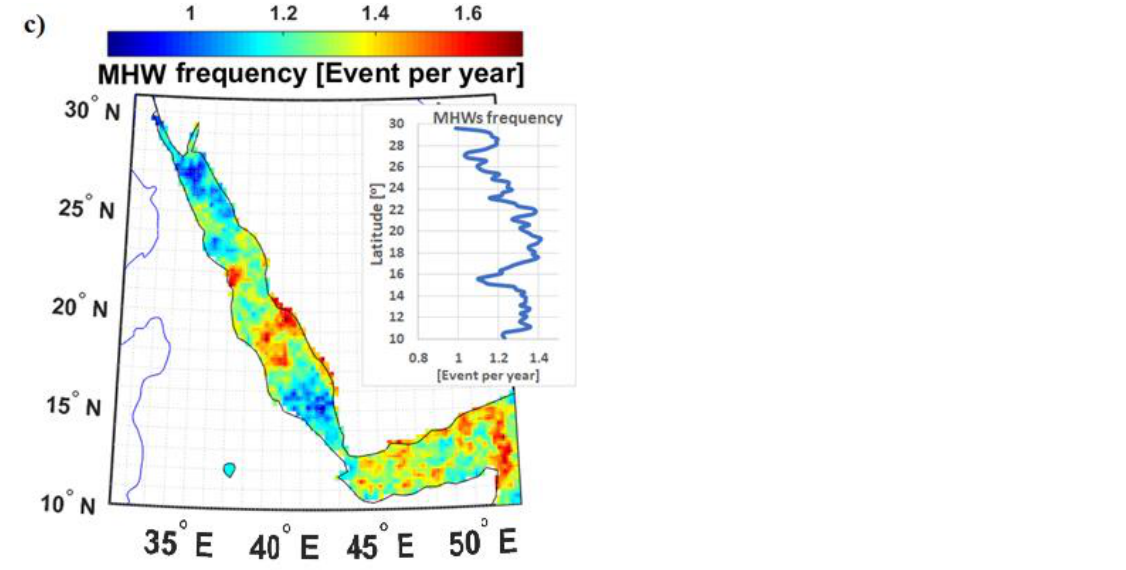
Figure 20. Marine heat wave (MHW) spatial/temporal characteristics over Red+. The latitudinal changes in annual average MHW intensity ( a ), MHW duration ( b ), and MHW frequency ( c ) are also shown.